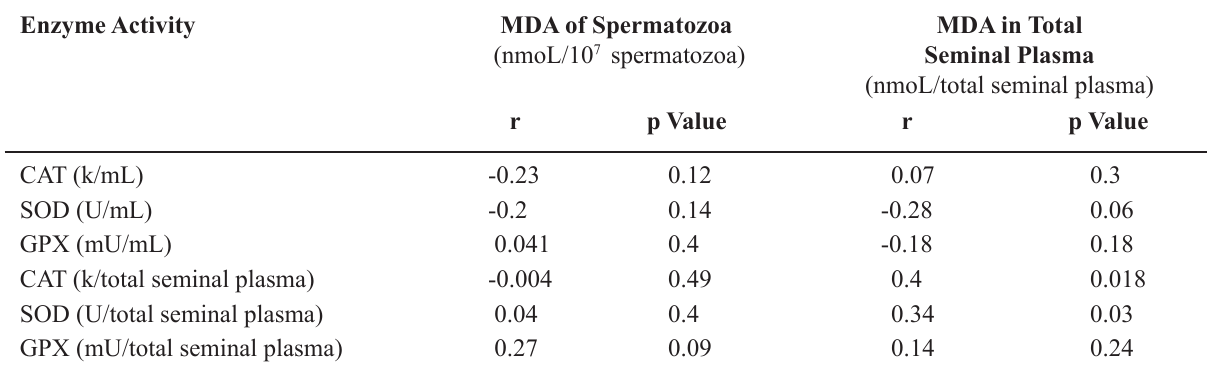
Table 4 – Correlations between catalase (CAT), superoxide dismutase (SOD) and glutathione peroxidase (GPX) activities with malondialdehyde (MDA) content of spermatozoa and seminal plasma from asthenozoospermic (n = 30)